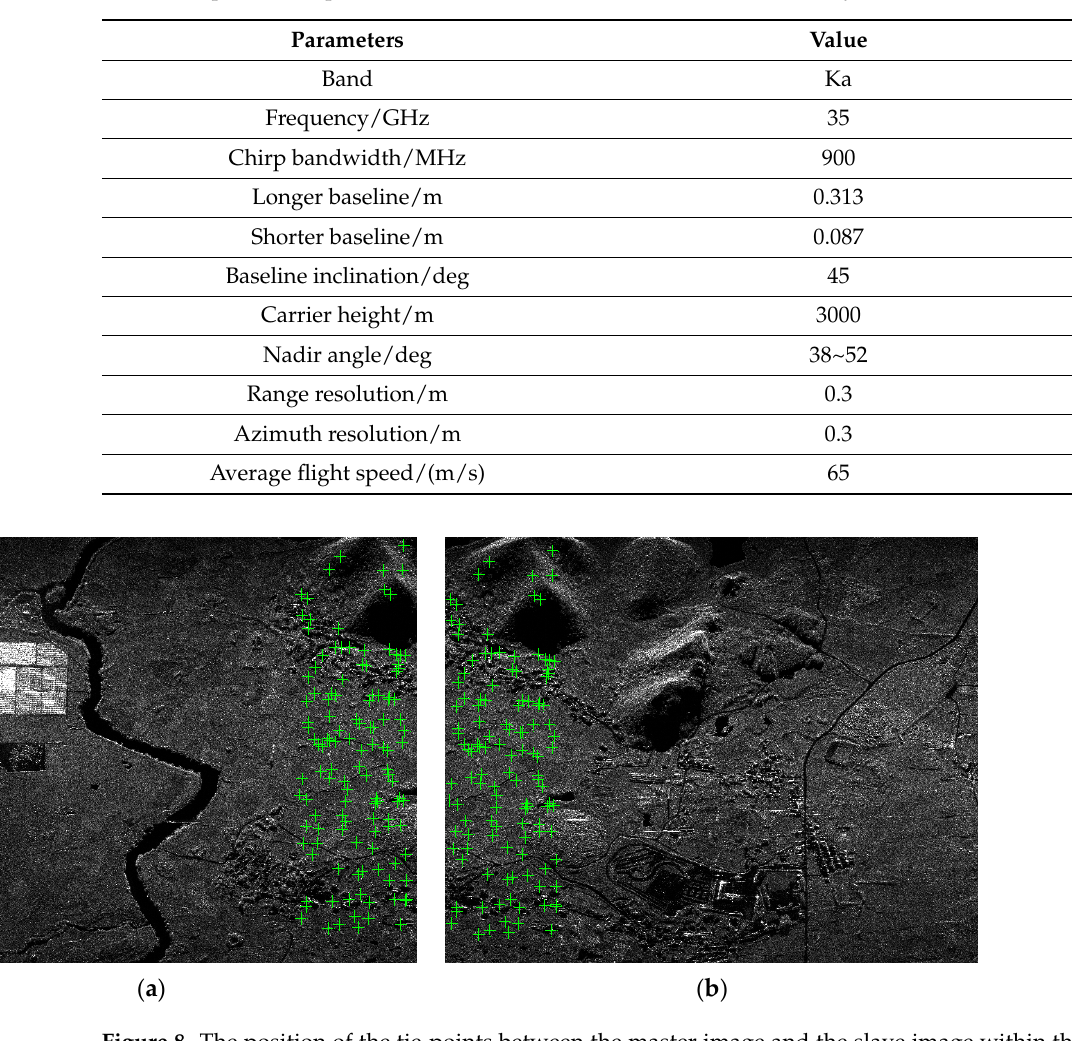
Table 1. Experimental parameters of the airborne millimeter-wave InSAR system.